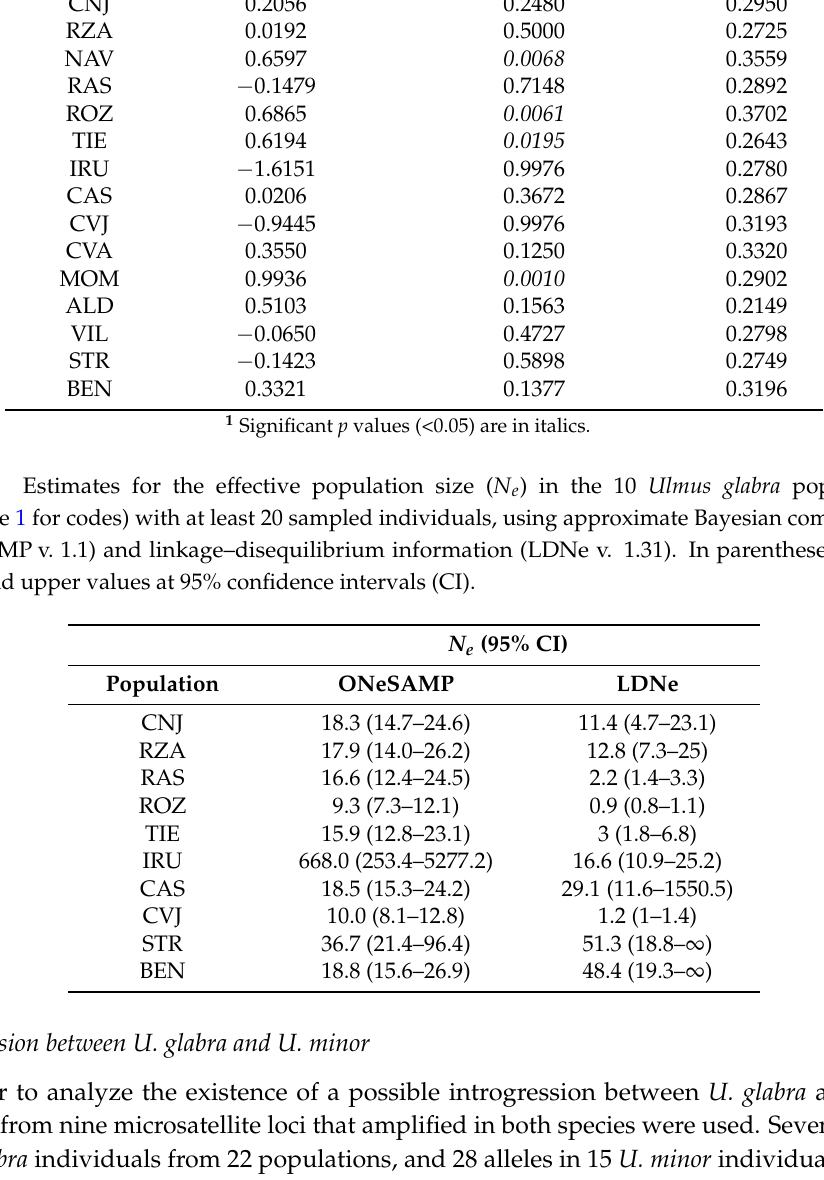
Table 4. Detection of genetic bottlenecks in the 15 Ulmus glabra populations (see Table 1 for codes) with at least 10 sampled individuals, using the T 2 statistic and p -values of the Wilcoxon’s signed rank test under the two-phase model (TPM) as implemented in Bottleneck v. 1.2, and mean values over loci for the M -ratio as calculated in Arlequin v. 3.5. Population T 2 Statistic Wilcoxon’s Test ( p values) 1 M -ratio CNJ 0.2056 0.2480 0.2950 RZA 0.0192 0.5000 0.2725 0.6597 0.0068